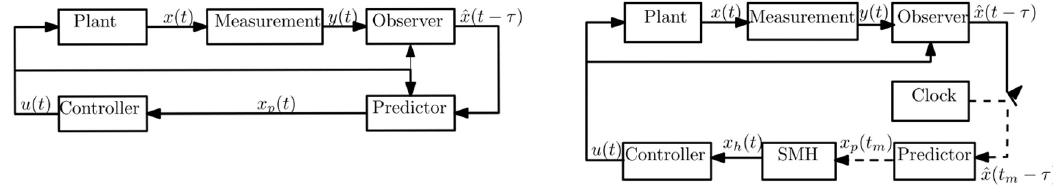
Fig 1. Block diagram of continuous control (CC, left) and periodic intermittent control (periodic IC, right) with system- matched hold (SMH) [5]. Solid and dashed lines carry continuous and intermittent communication, respectively. Due to measurement delay τ , the current measurement, y ( t ), reflects the state of the plant, x , at t − τ , so the observer can only estimate the observer state ^ x ð t (cid:0) t Þ . In CC, the predictor operates continuousely to generate the predicted state x ( t ) from which the control p signal u ( t ) is derived. In periodic IC, the predictor operates only at the evenly spaced triggers generated by the clock. At the time of the m –th trigger, t , the predictor generates x ( t ) that provides the initial condition to the SMH. The SMH generates the hold state m p m x h ( t ), which approximates the predicted state in open-loop based on the dynamics of the closed-loop system. External inputs, reflecting task goal, noise and disturbances, are omitted for